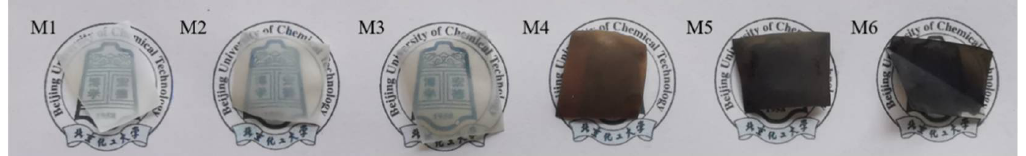
Figure 3. The morphology of M1–M6 membranes.